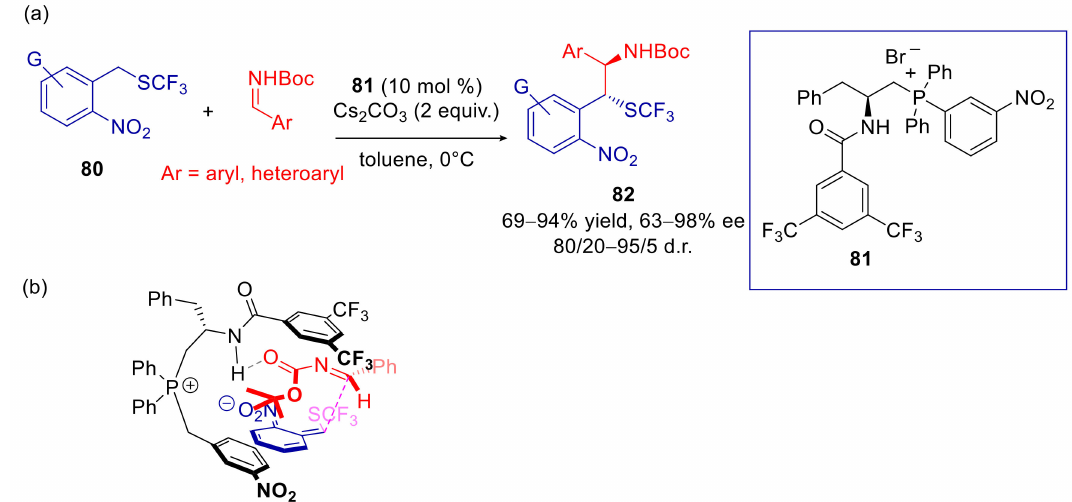
Scheme 26. Arylogous Mannich reaction of 2-(trifluoromethylthiomethyl)nitroarenes catalyzed by chiral phosphonium salt 81 . ( a ) Scope of reaction; ( b ) Plausible transition